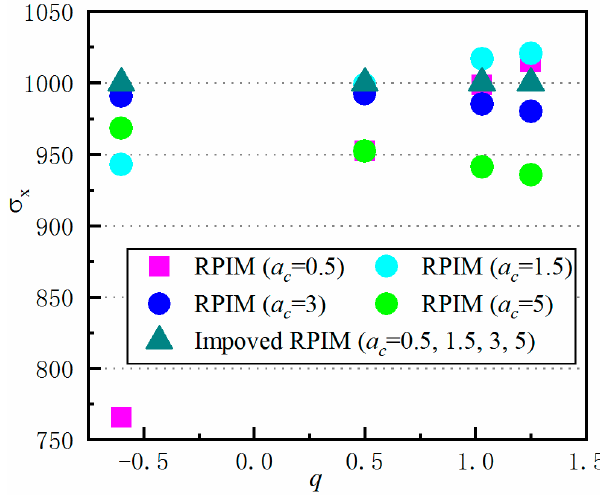
Figure 7. Investigation on sensitivity of stress solution to shape parameters.